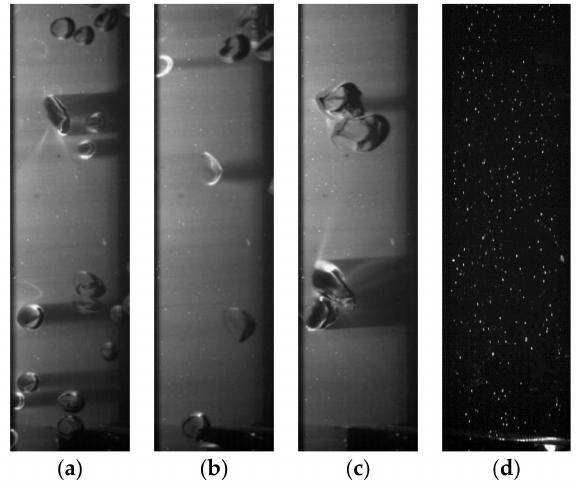
Figure 2. Single frames of the flow at Re = 6600 and β = 0.03: ( a ) “small” bubbles; ( b ) “medium” bubbles; ( c ) “large” bubbles; ( d ) “small” bubbles without Rhodamine in the test